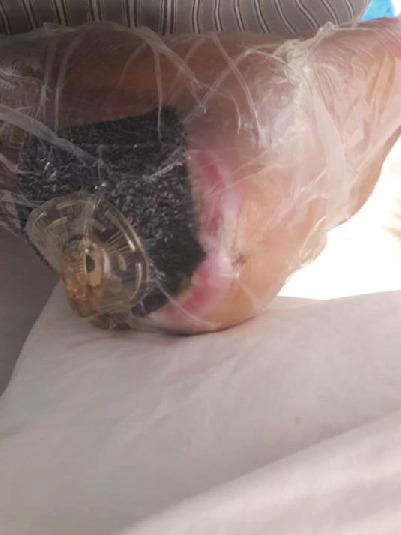
NPWT application.